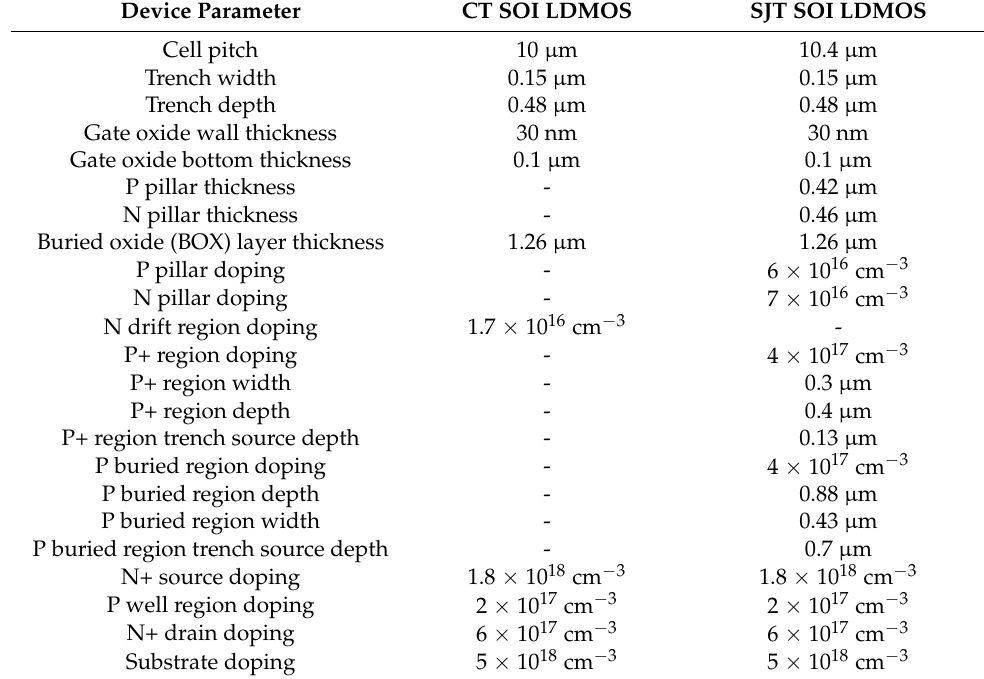
Figure 1. The cross-section schematic of ( a ) the SJT SOI LDMOS and ( b ) the CT SOI LDMOS. Table 1. Device parameters for simulations. Device